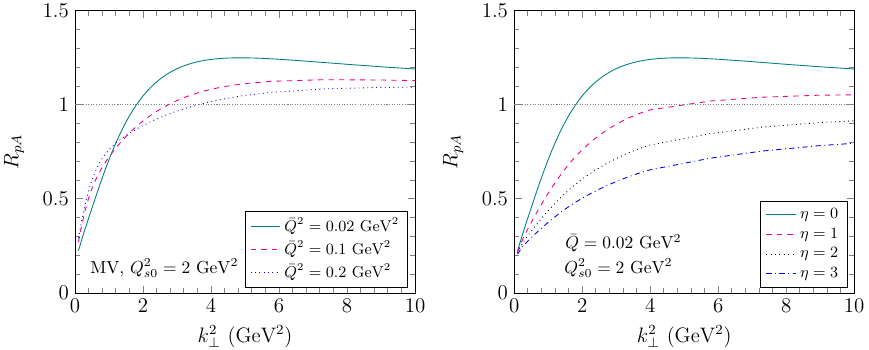
Figure 32. Nuclear modification factor for single semi-inclusive hadron production displaying a Cronin peak and its disappearance. ( Left ) Dependence on the virtuality. ( Right ) Dependence on rapidity of the produced particle. In this figures ¯ Q 2 = z ( 1 momentum fraction of the hadron relative to the virtual photon, and is chosen to be close to unity. Figure from the work in